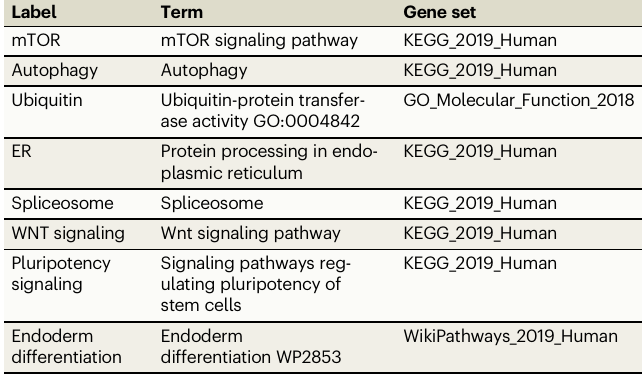
Table 2 | Selected enrichments from RNA-seq time course